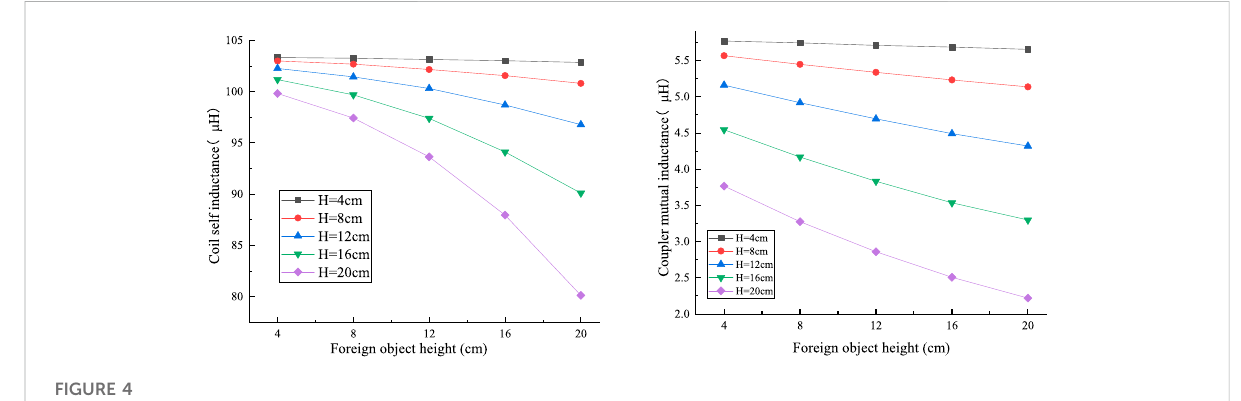
FIGURE 4 In fl uence of the changes in foreign object height on coupler